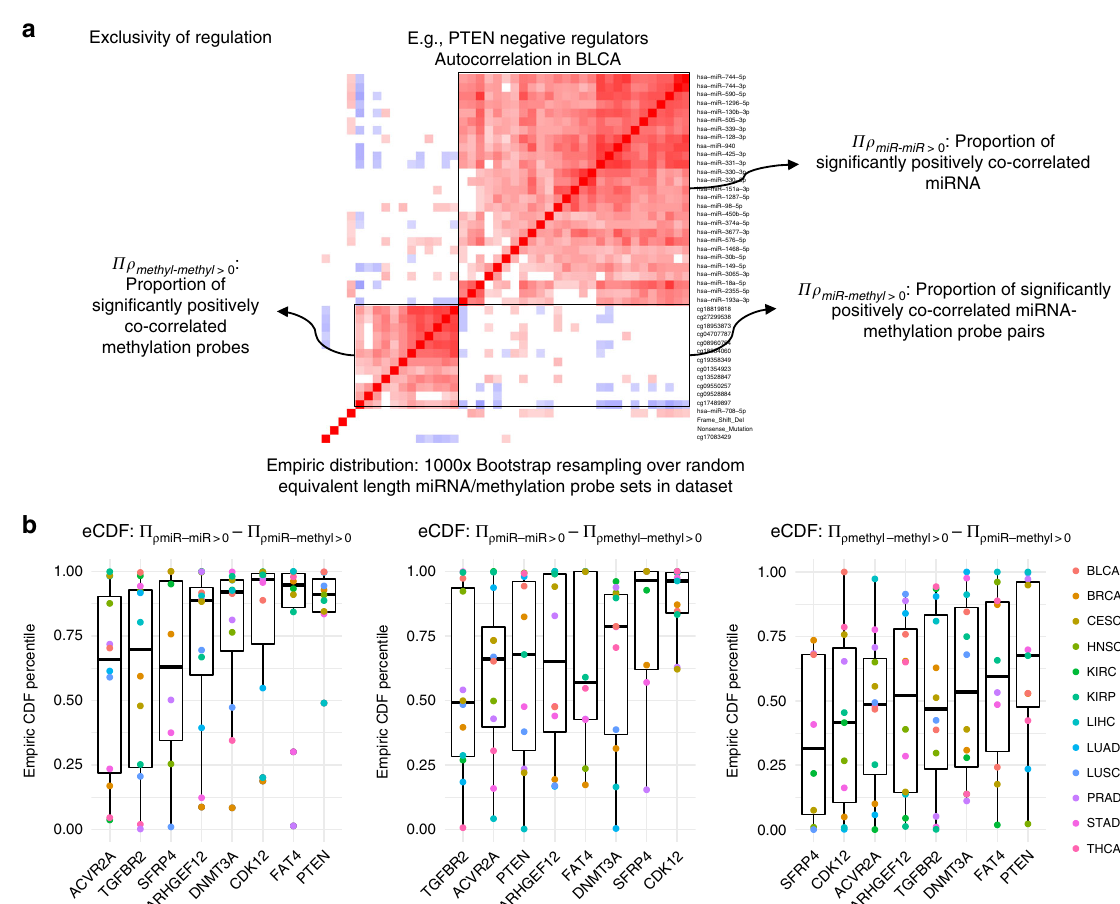
Fig. 4 The approach used to determine the exclusivity of each mode of gene regulation on expression for the TSG considered. a Depiction of the autocorrelation heatmap for the expression of the various negative regulators of the tumour suppressor gene, and the variables considered and their meaning, as depicted. b Plots depicting the spread of the percentiles on the empiric cumulative density function (CDF) for the distributions for the pairwise differences of the variables identi fi ed in a through a bootstrapping-based analysis, as described in the Methods section. Centre line of boxplots depicts median, bounded by interquartile range (IQR), and whiskers extending to 1.5 times the